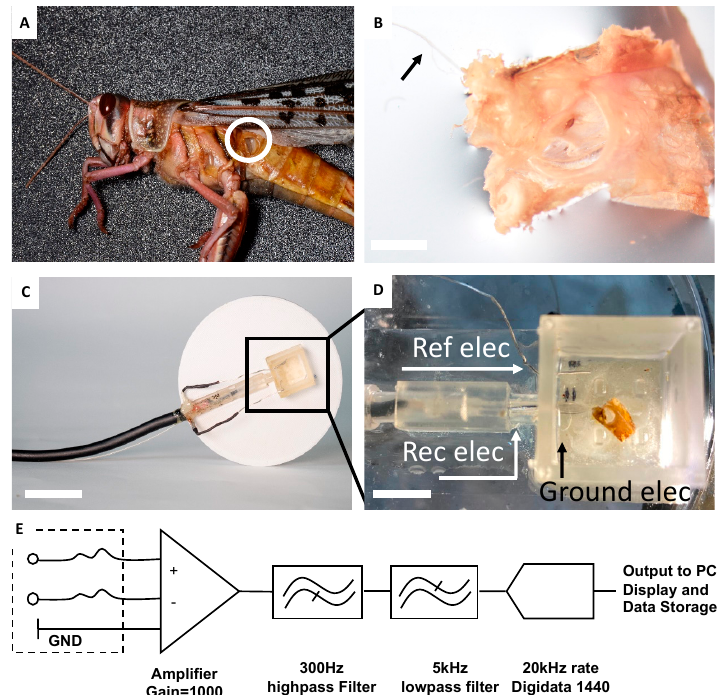
Figure 2. Characterization of the Ear-Chip response to sounds ( A ) The locust’s tympanal organ ( B ). Isolated locust’s tym- panal organ with an intact auditory nerve (black arrow). Scale bar 0.1 cm ( C ) A microfluidic chip connected to a custom designed suction electrode. Scale bar 2 cm ( D ) Locust auditory organ inside a special chip designed for best electrophysi- ological recording. The locust auditory nerve sucked into the suction electrode prior to recording. Scale bar 0.6 cm. Ref elec: Reference electrode , Rec elec: Recording electrode , Ground elec: Ground electrode . ( E ) Diagram of the electrical connections of the Ear-Chip.